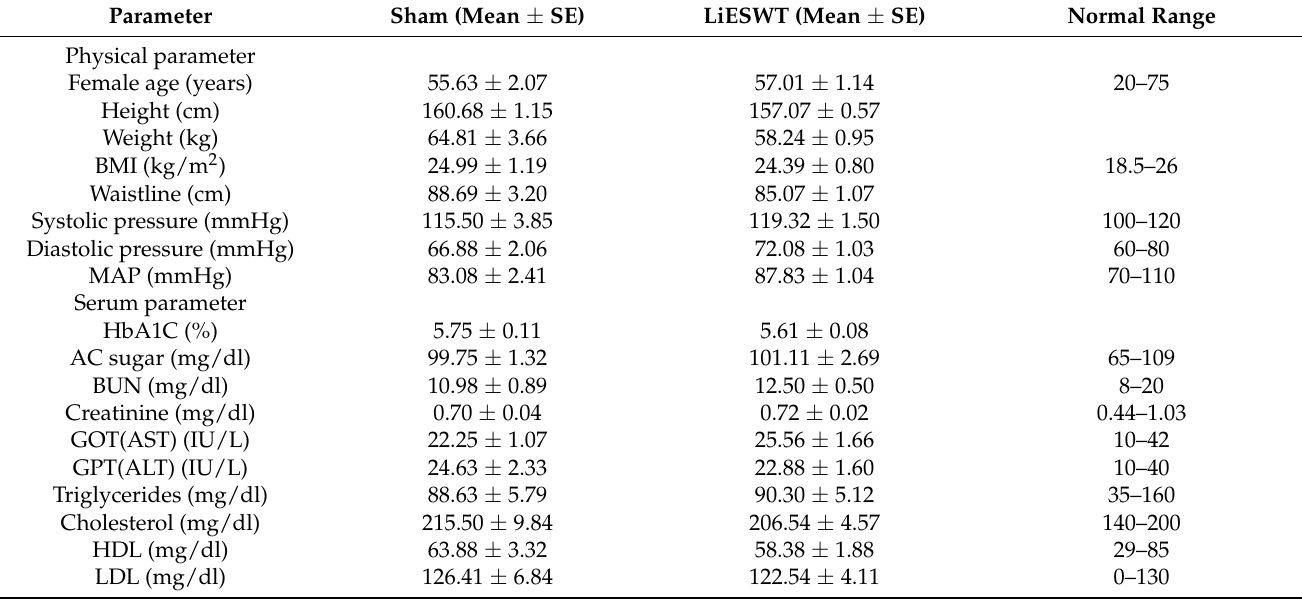
Table 2. Baseline characteristics of overactive bladder (OAB)